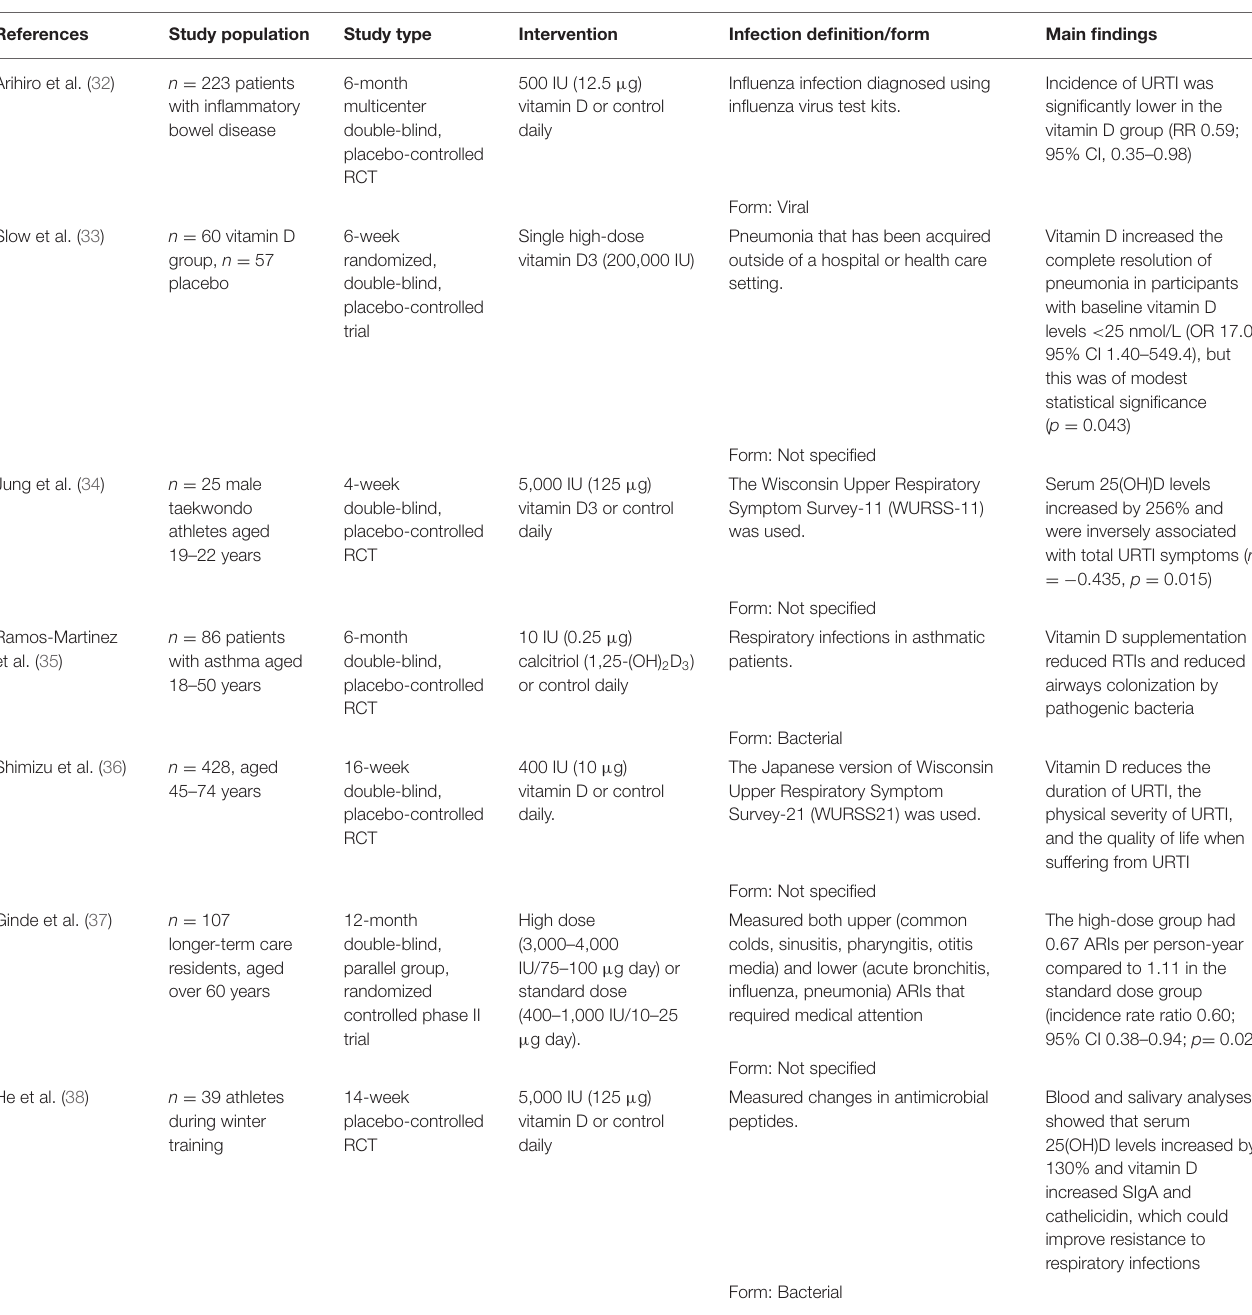
TABLE 2 | Summary of recent RCTs investigating the effect of vitamin D supplementation on RTIs in